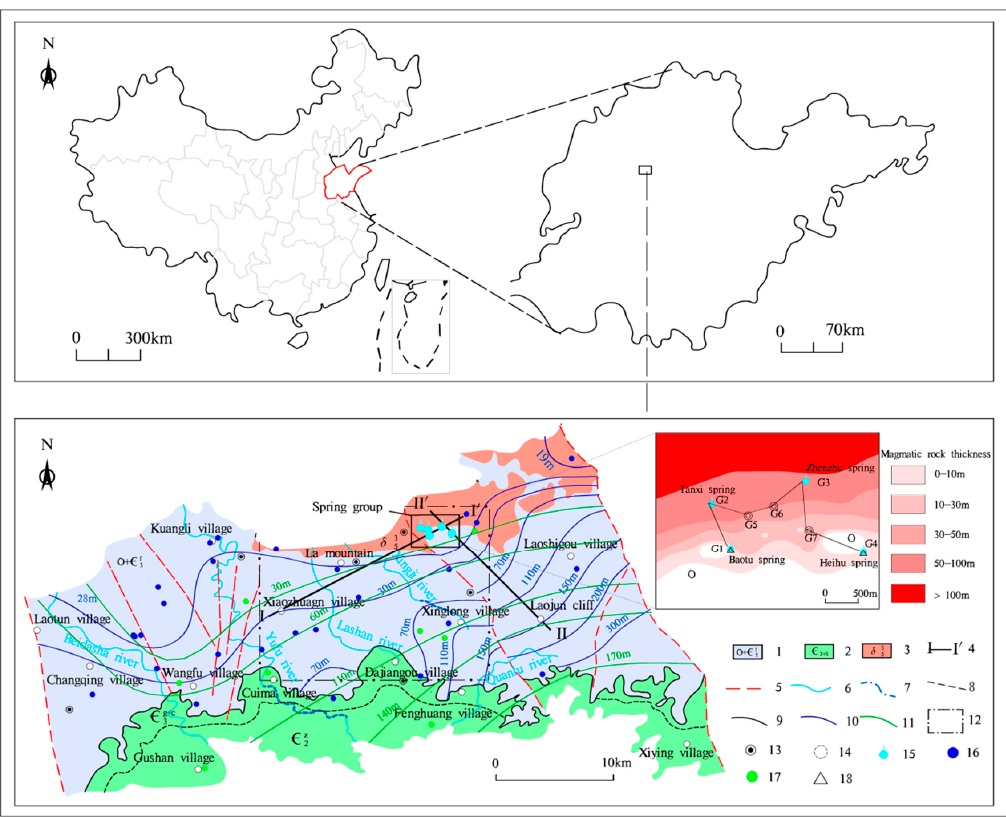
Figure 1. Geological outline of the Jinan spring area. 1: Exposed and semi-exposed Ordovician limestone-Cambrian Fengshan Formation limestone; 2: Cambrian Changshan Formation limestone-Zhangxia Formation limestone; 3: magmatic rock; 4: section; 5: fault; 6: river; 7: the river recharge area; 8: Cambrian Changshan Formation bottom limit; 9: Cambrian Fengshan Formation bottom limit; 10: the aquifer isohydrographic level of the Ordovician and Fengshan Formation of the Cambrian; 11: the aquifer isohydrographic level of the Cambrian Zhangxia Formation; 12: tracer test area; 13: recharge point; 14: place; 15: spring group; 16: the aquifer water level monitoring point of the Ordovician and Cambrian Fengshan Formation; 17: the aquifer water level monitoring point of the Cambrian Zhangxia Formation; 18: spring water level monitoring point.